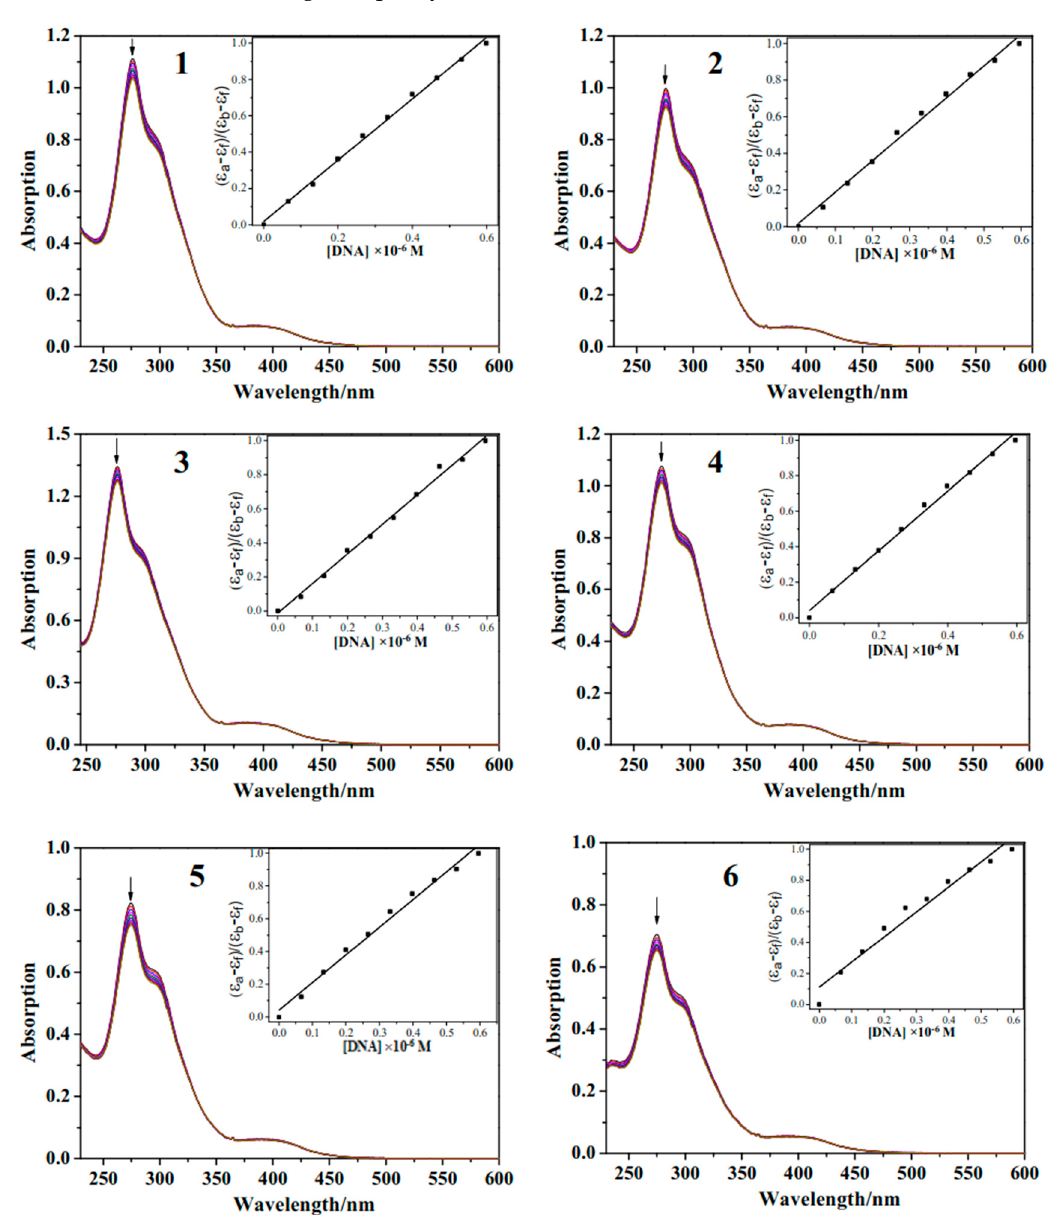
Figure 2. Representative UV–vis absorption titrations of arene Ru(II) complexes upon the addition of c-myc G-quadruplex DNA in a 10 mM Tris-HCl buffer (pH 7.4) containing 100 mM KCl. The arrow shows the absorbance change with the increase in c-myc G-quadruplex DNA concentrations.